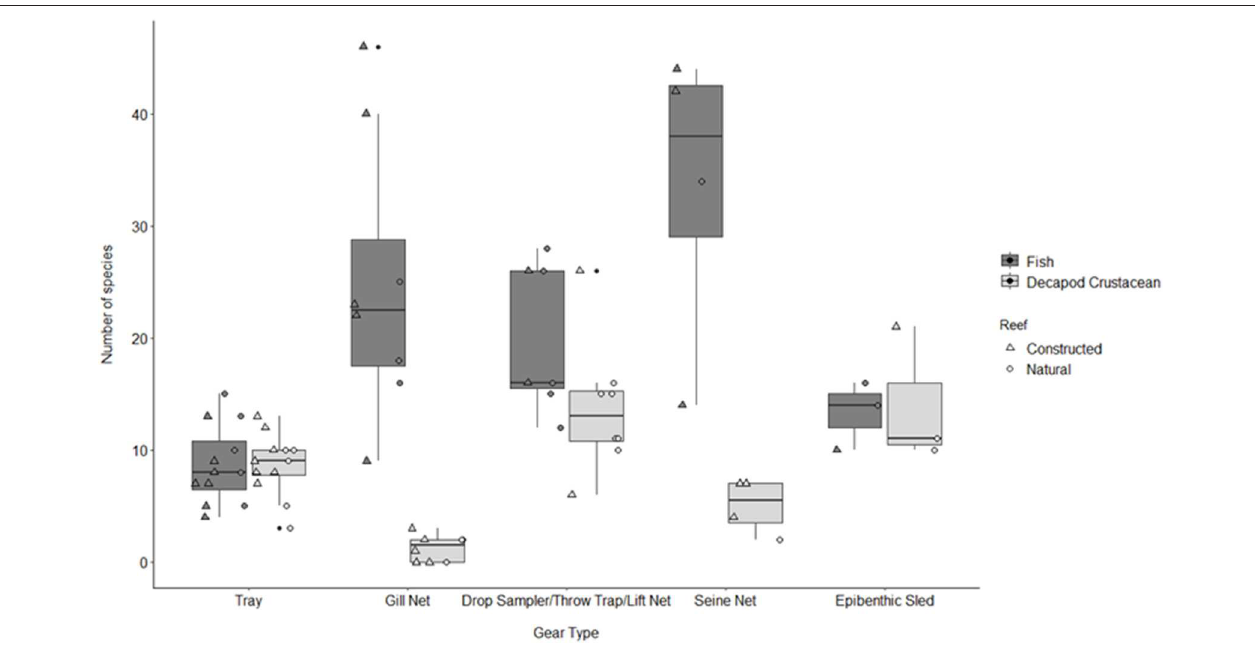
FIGURE 3 | Boxplot of number of fish and decapod crustacean species presented by gear type TR, tray; GN, gill net; DS, drop sampler; LN, lift net; TT, throw trap; SN, seine; ES, epibenthic sled. Box represents 25, 50, and 75% quantilets, with whiskers at ± 1.5*IQR.